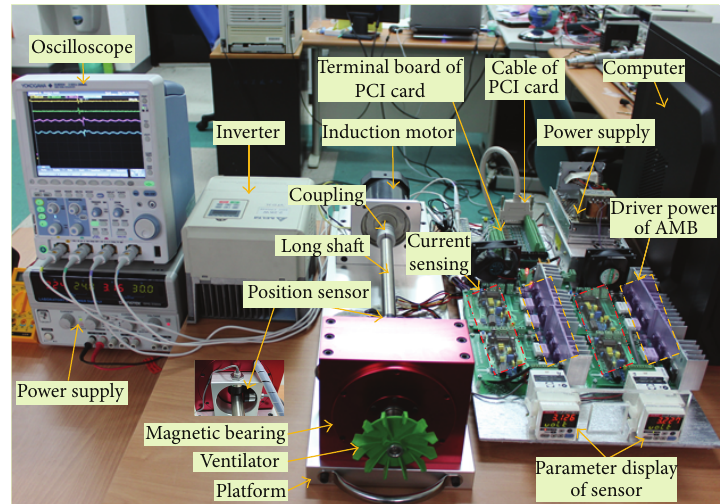
Figure 15: Photograph of the experimental setup.